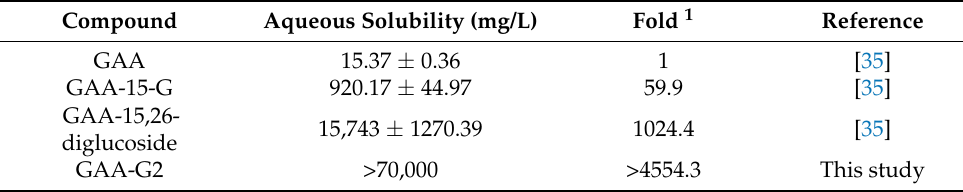
Table 1. Aqueous solubility of ganoderic acid A (GAA) and its derivatives at 25 °C. Compound